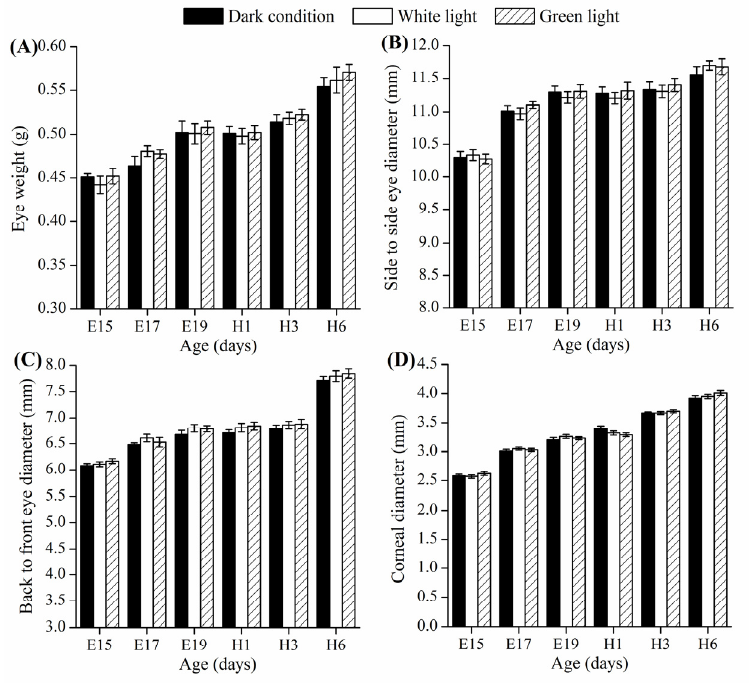
Figure 3. (A) Eye weight, (B) side to side or (C) back to front eye diameters, and (D) corneal diameter of chick embryos on embryonic days 15, 17, and 19 (E15, E17, and E19) and newly hatched chicks on posthatch days 1, 3, and 6 (H1, H3, and H6) incubated under light- emitting diodes–based white light, green light or dark condition. Values are presented as means±standard error (n =